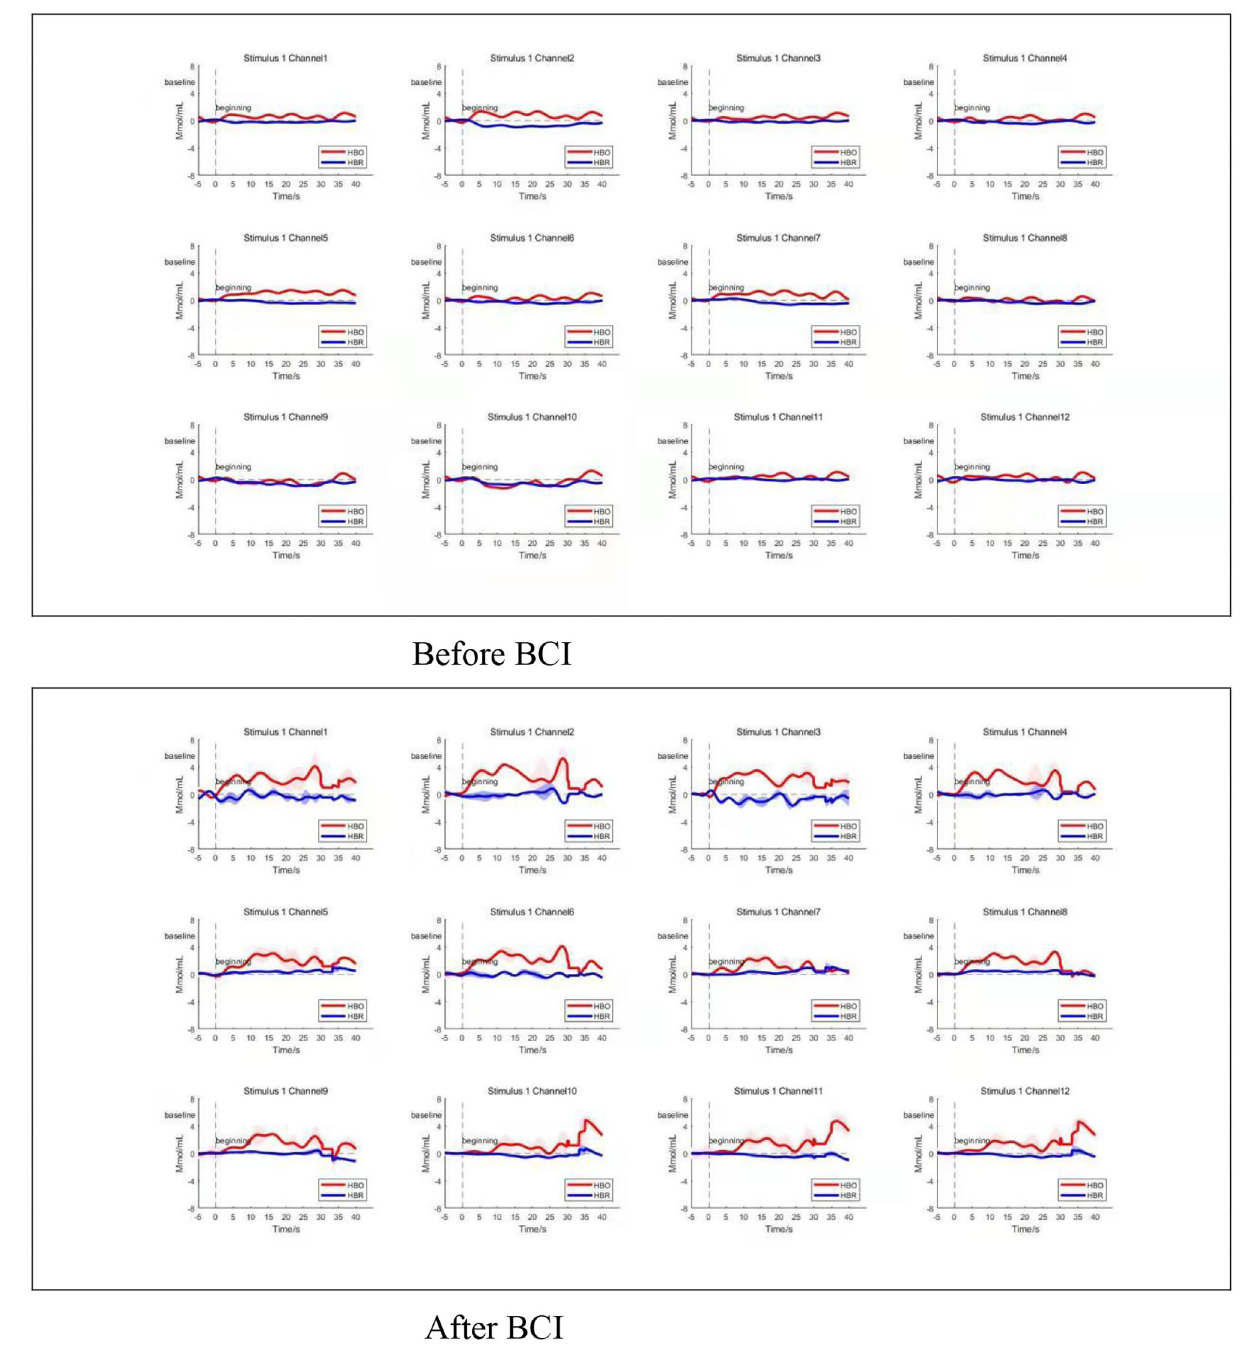
FIGURE 5 | Average time series of HRF. Changes in average oxy-Hb amplitude increased at any time point in the whole four ROIs after BCI training during the grasping task (bottom panel). Channels 1–4 located in left M 1 , and channels 5–8 located in right M 1 . Channels 9 and 10 located in the left frontal polar cortex, and channels 11 and 12 located in the right frontal polar cortex. Top three panels show the HRF change before BCI training, bottom three panels show the HRF change after BCI training. HBO refers to oxy-Hb. HBR refers to